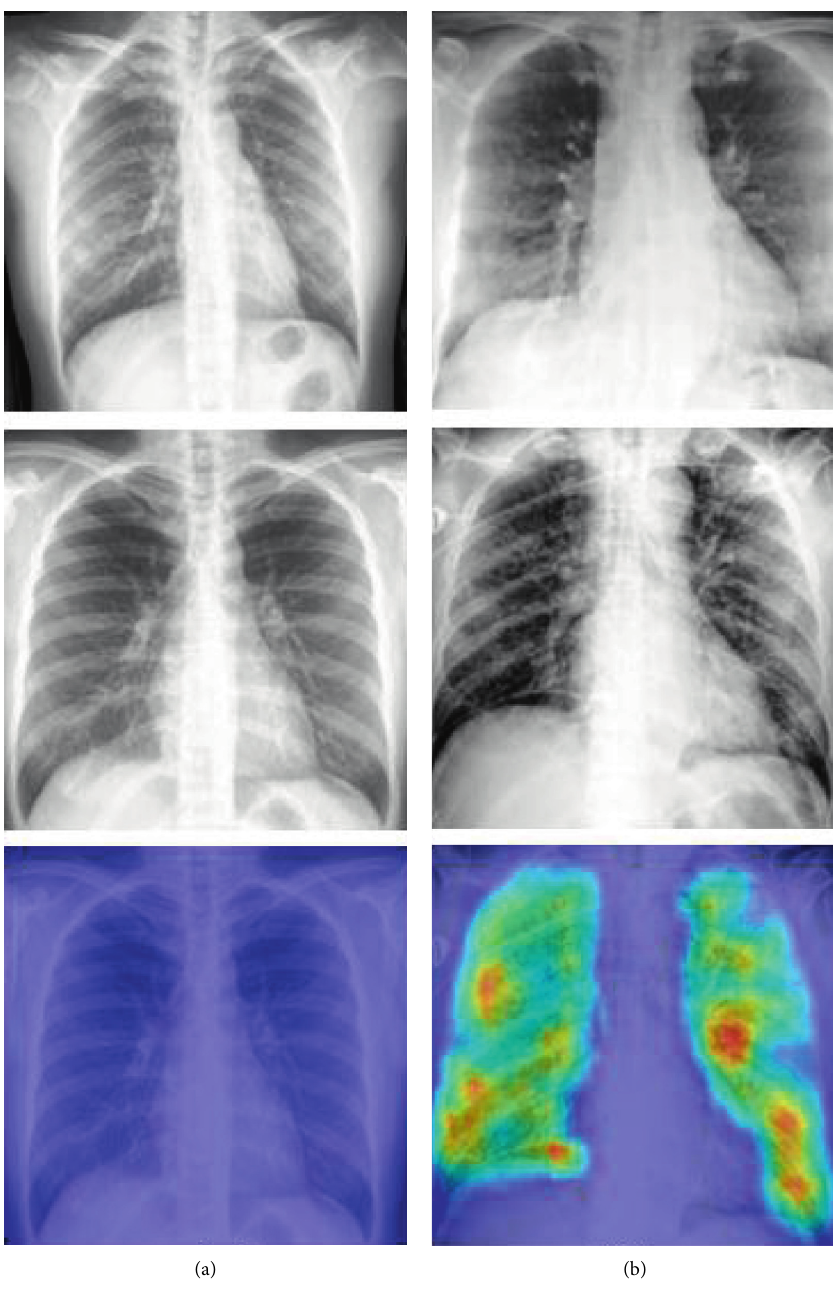
Figure 1: Sample preprocessed CT volume of the human lungs: (a) normal and (b) COVID-19 pneumonia patient